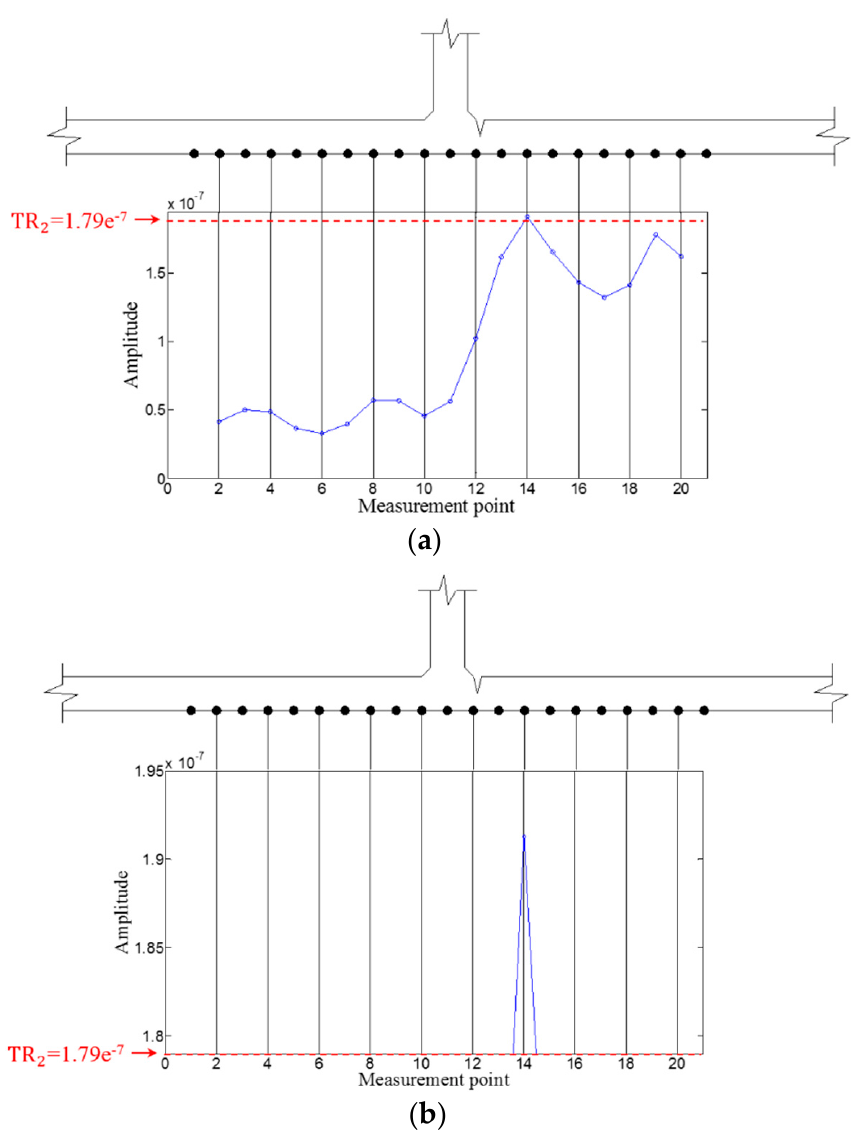
Figure 10. ZLCC values of each measurement node in the crack case at 150 kHz ( a ) before and ( b ) after applying TR 2 .